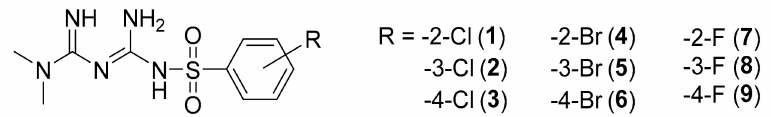
Figure 1. Chemical structure of tested biguanide derivatives—metformin sulfonyl halides ( 1 – 9